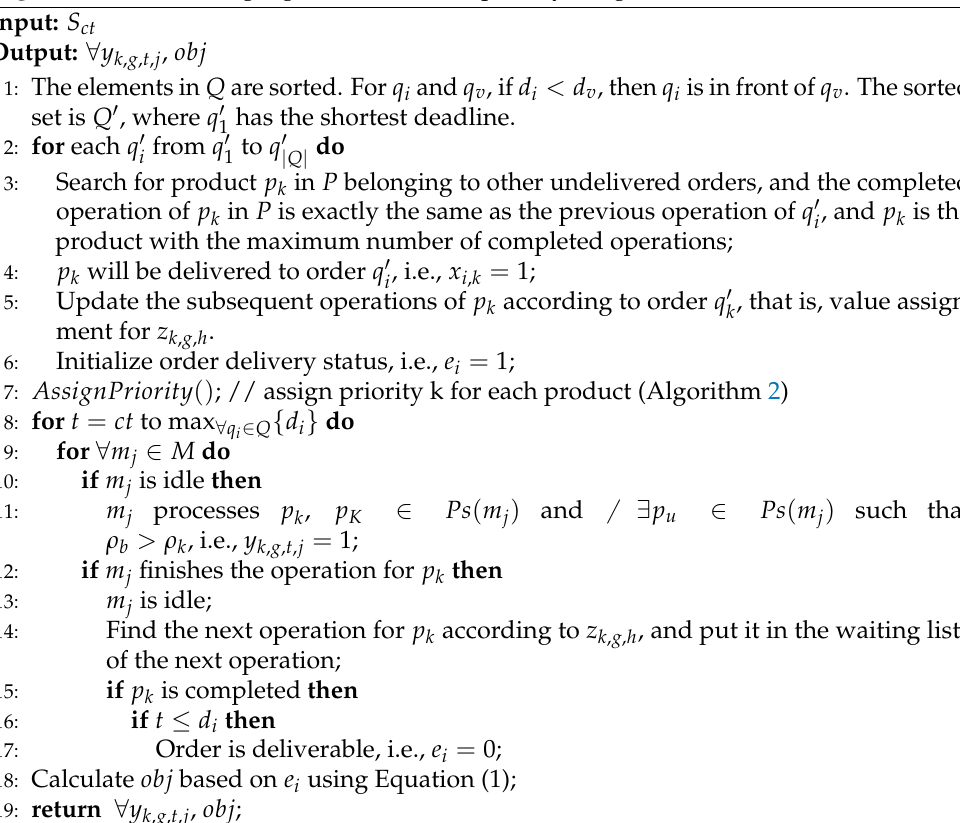
Figure 4. Basic scheduling Algorithm 1 Scheduling algorithm based on priority